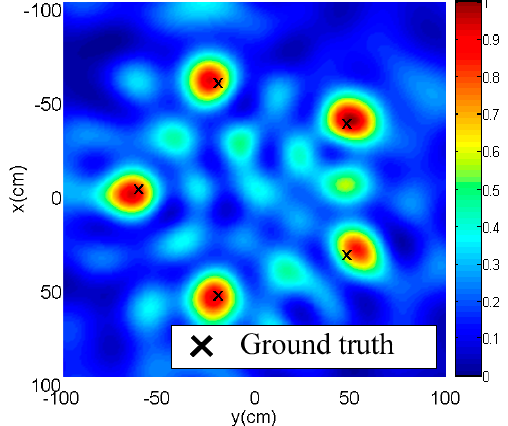
Figure 7. The final spatial spectrum.